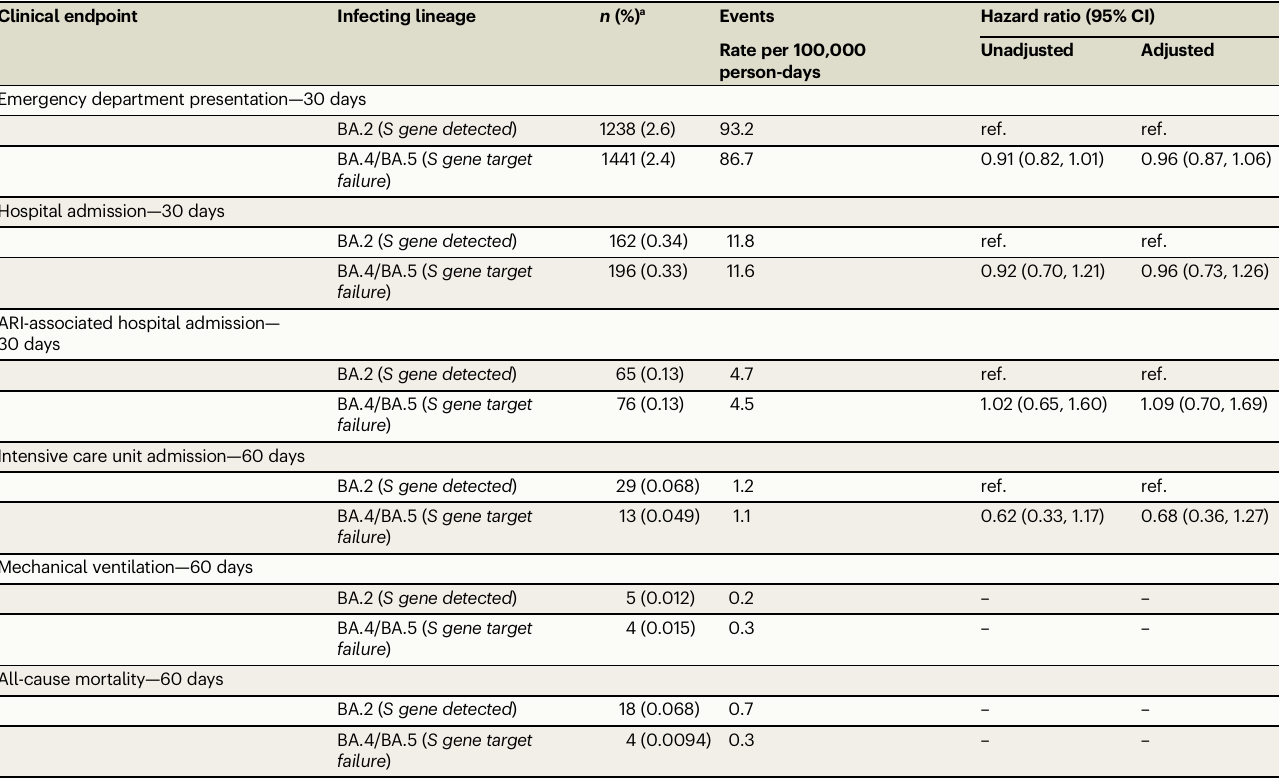
Table 3 | Association of infecting lineage with risk of severe clinical outcomes among cases tested 29 April, 2022 to 29 July, 2022 Clinical